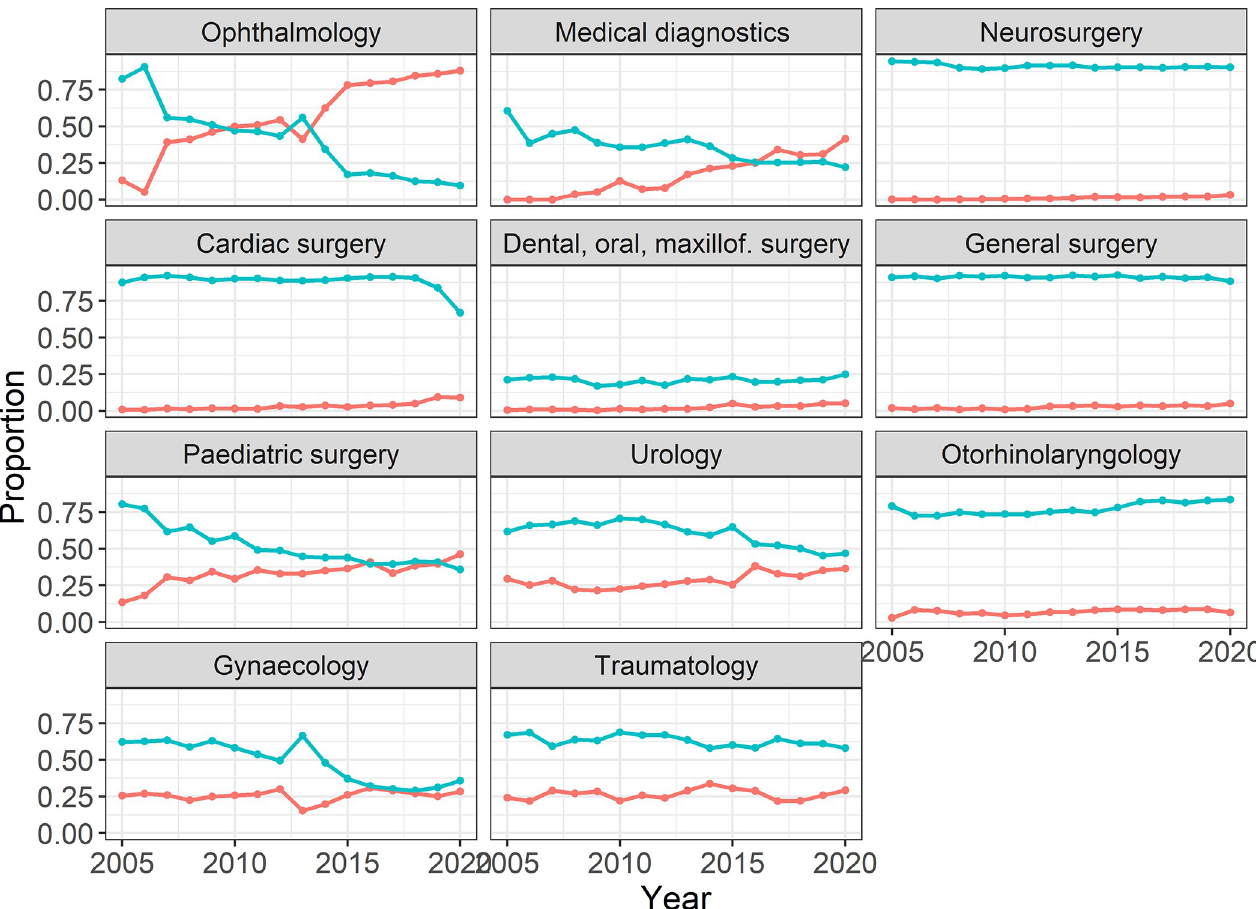
Fig 3. Supraglottic airway device (red) use over time compared to oral intubation (turquoise) trends over time by operative/medical specialty.